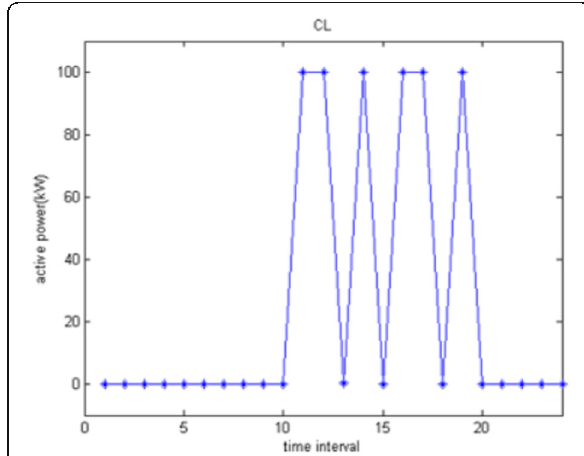
Fig. 16 Active power schedule of the Removable Load